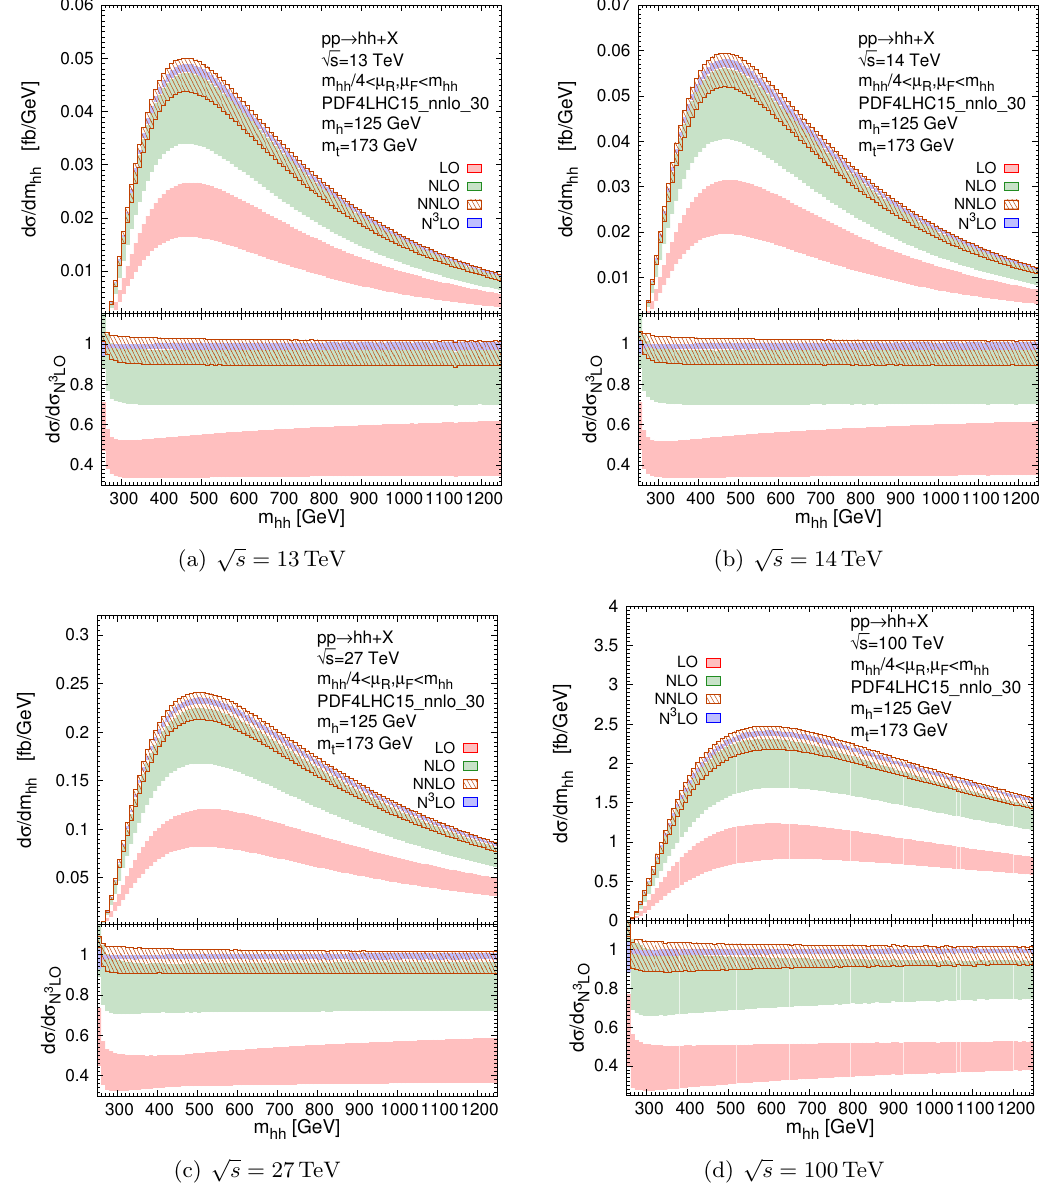
Figure 12 . Invariant mass distributions for the Higgs boson pair production in proton-proton p collisions with s = 13 ; 14 ; 27 ; 100 TeV. The bands represent the scale uncertainties. The red, green, brown and blue bands correspond to the LO, NLO, NNLO and N 3 LO predictions, respectively. The bottom panel shows the ratios to the N 3 LO distribution.